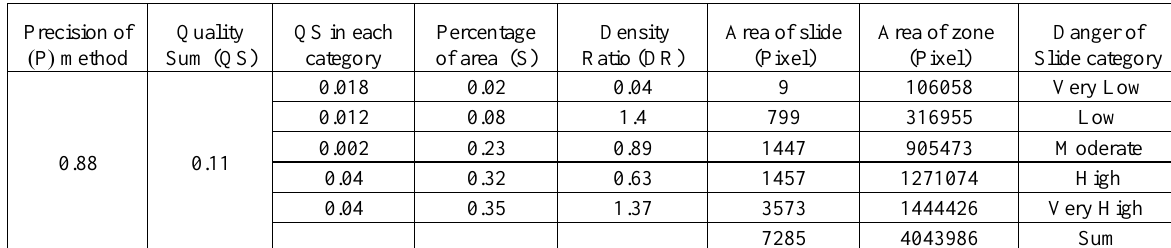
Table 4. Validation and accuracy of landslide hazard zonation using OR